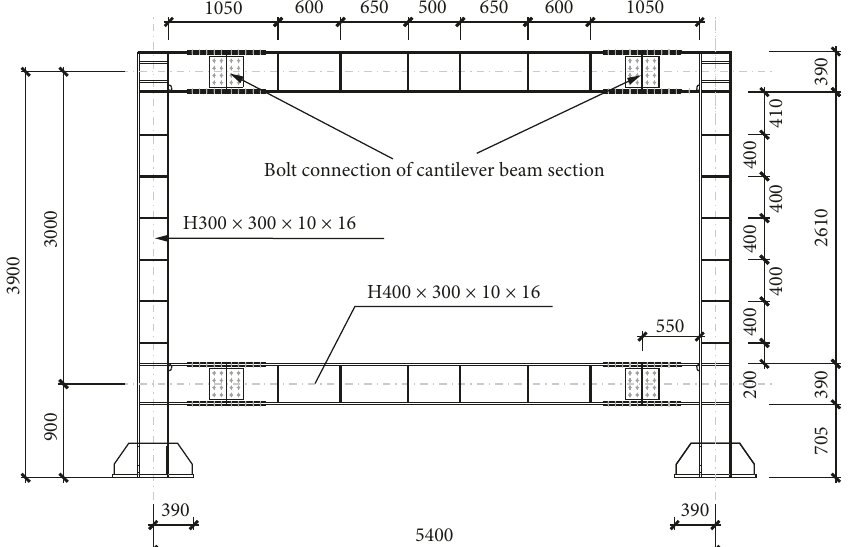
Figure 1: Geometric dimension elevation of the frame.